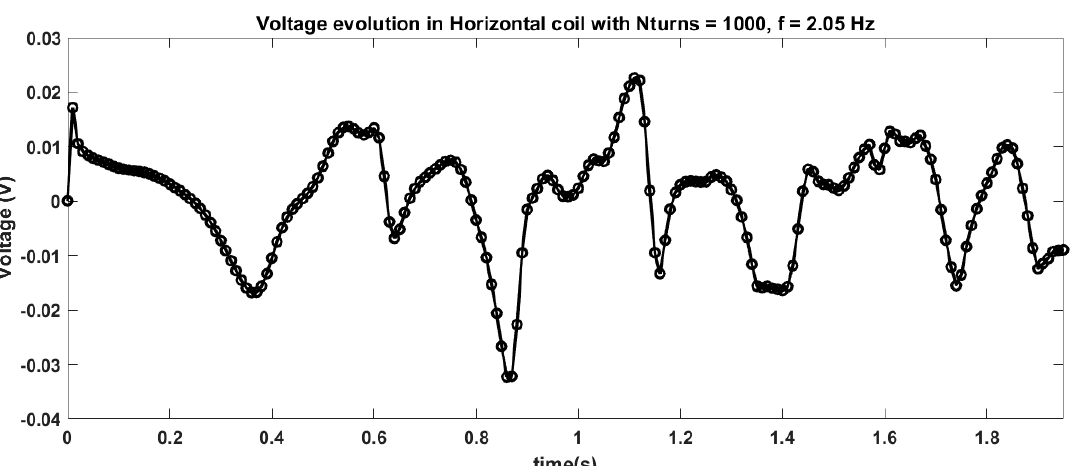
Figure A34. Voltage evolution for vertical coil with 1000 turns for case 7 of magnet arrangement and 2.05 Hz frequency of excitation.